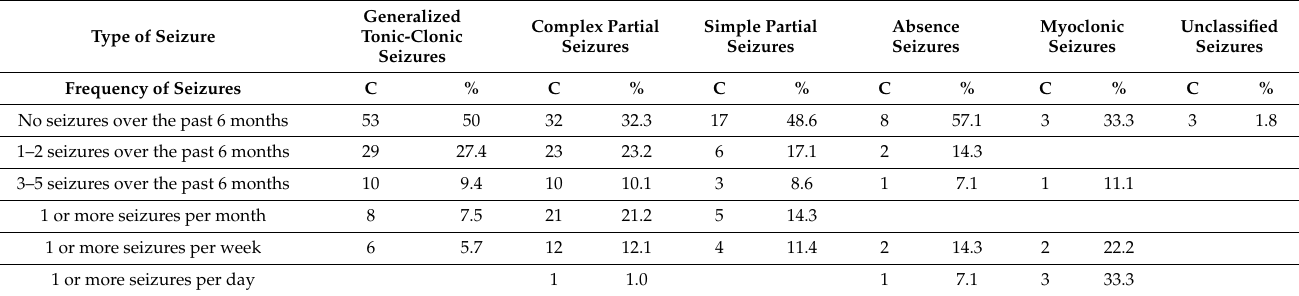
Table 2. Type and frequency of seizures.